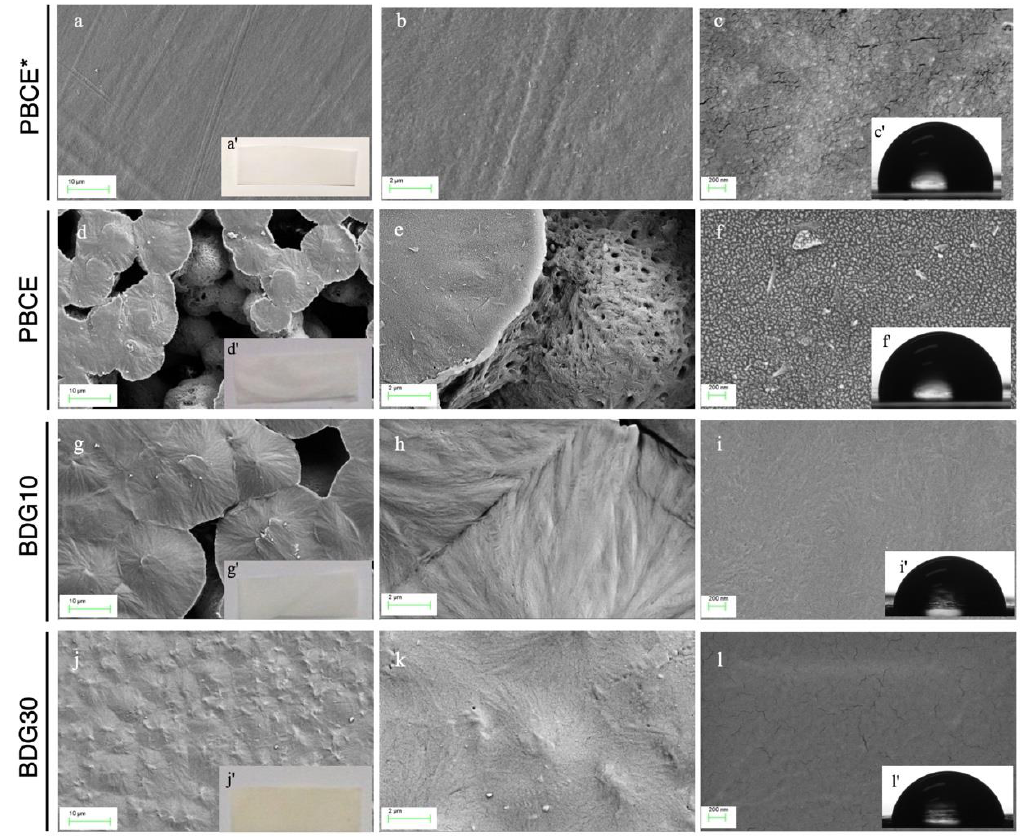
Figure 1. PBCE*, PBCE, BDG10 and BDG30 polymer films. Representative FESEM images of PBCE* ( a – c ), PBCE ( d – f ), BDG10 ( g – i ) and BDG30 ( j – l ) surface. The insets show optical photographs ( a I , d I , g I , j I )